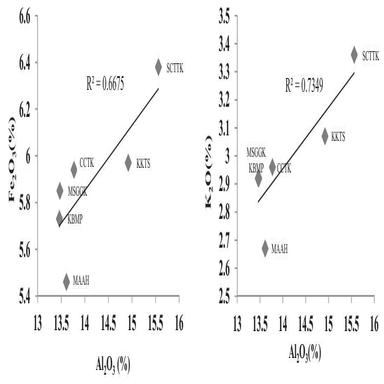
Linear relationship between Al2O3 and Fe2O3, and Al2O3 and K2O.